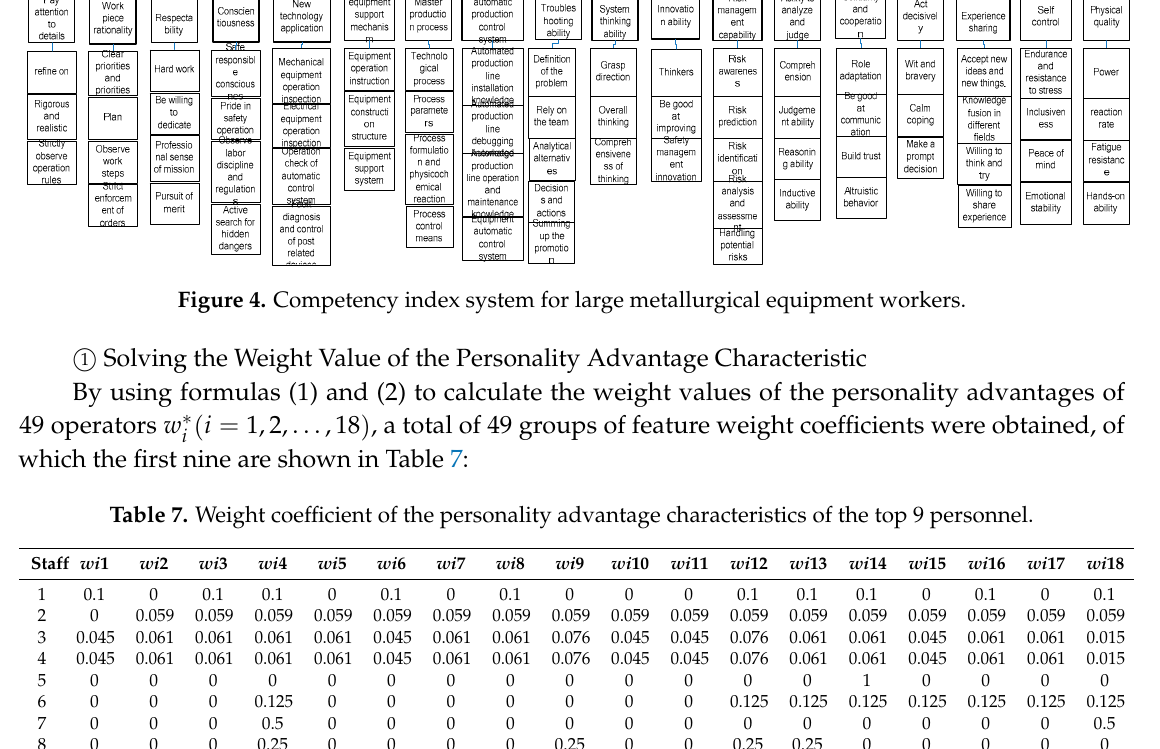
Table 7. Weight coefficient of the personality advantage characteristics of the top 9 personnel.